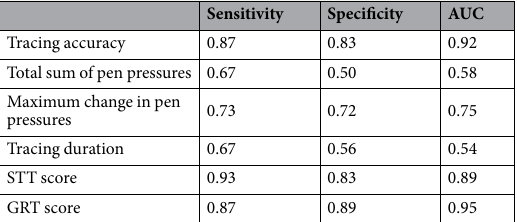
Sensitivity Specificity AUC